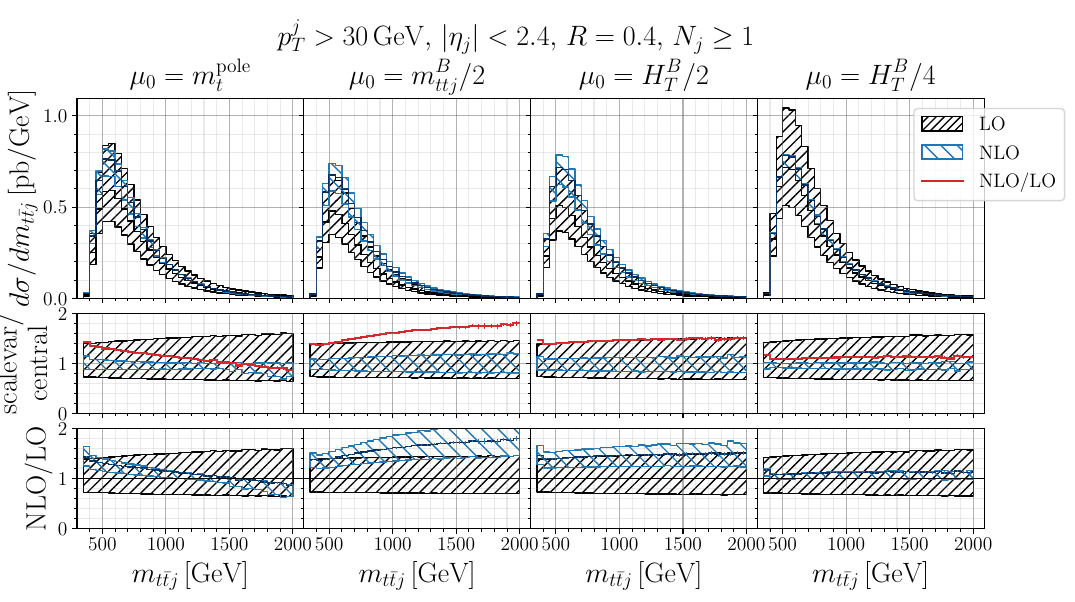
Figure 8 . Same as in figure 7, but for the m